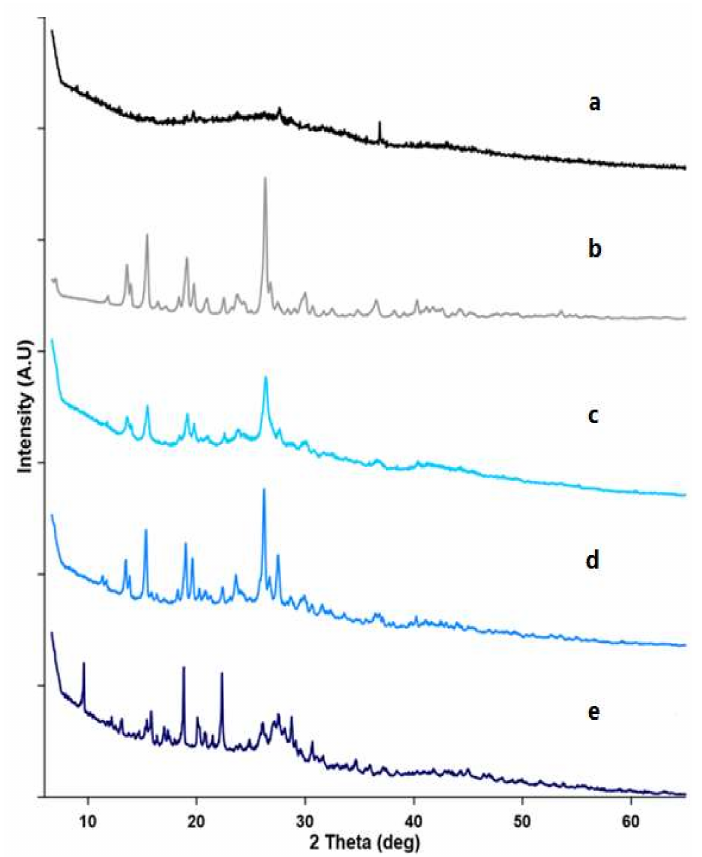
Figure 4. PXRD of following: ( a ) sulfonatocalix[4]naphthalene (C), ( b ) meloxicam (ME), ( c ) physical mixture (PM), ( d ) kneaded (KN), and ( e ) coevaporate (CO)